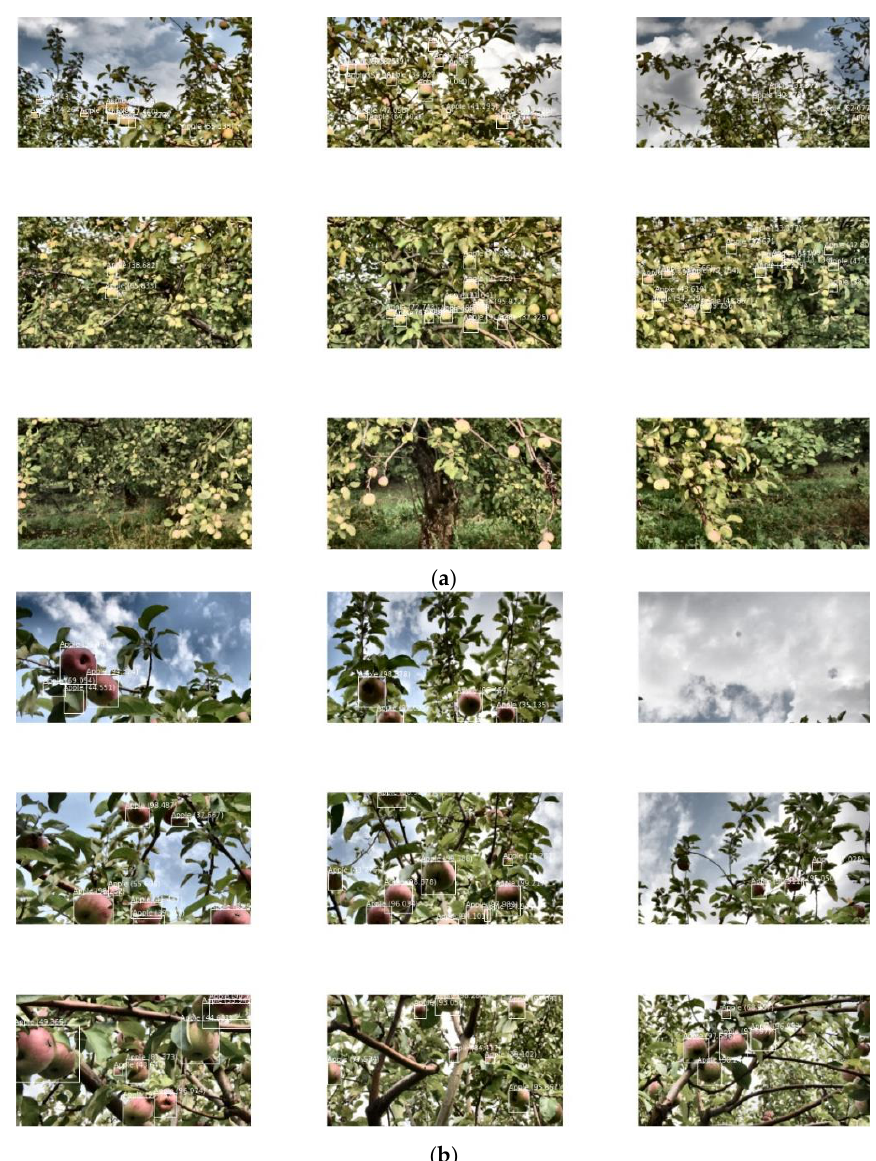
Figure 10. Fifty-seven ( a ) and 48 ( b ) apples found in the far-view canopy images after